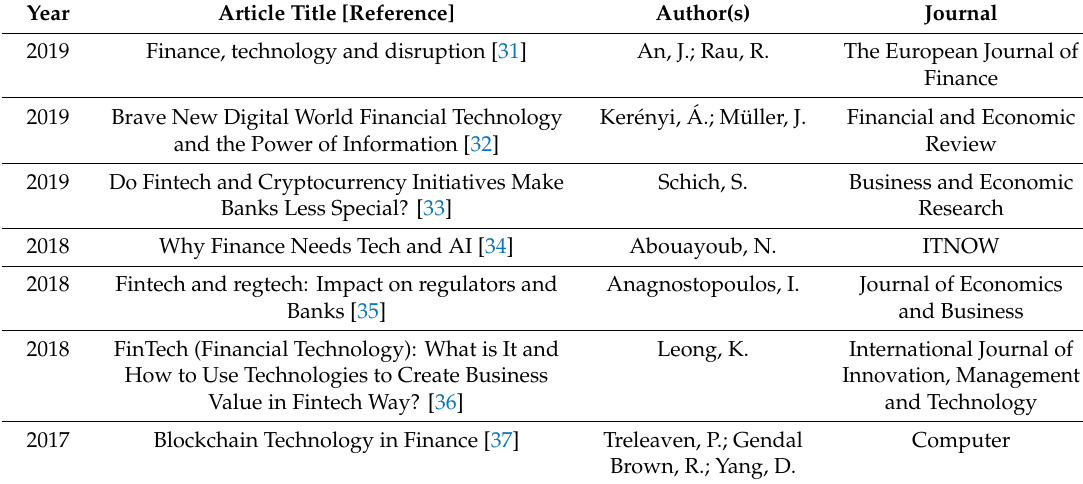
Table 2. Main literature reviewed in relation to the aim of the research